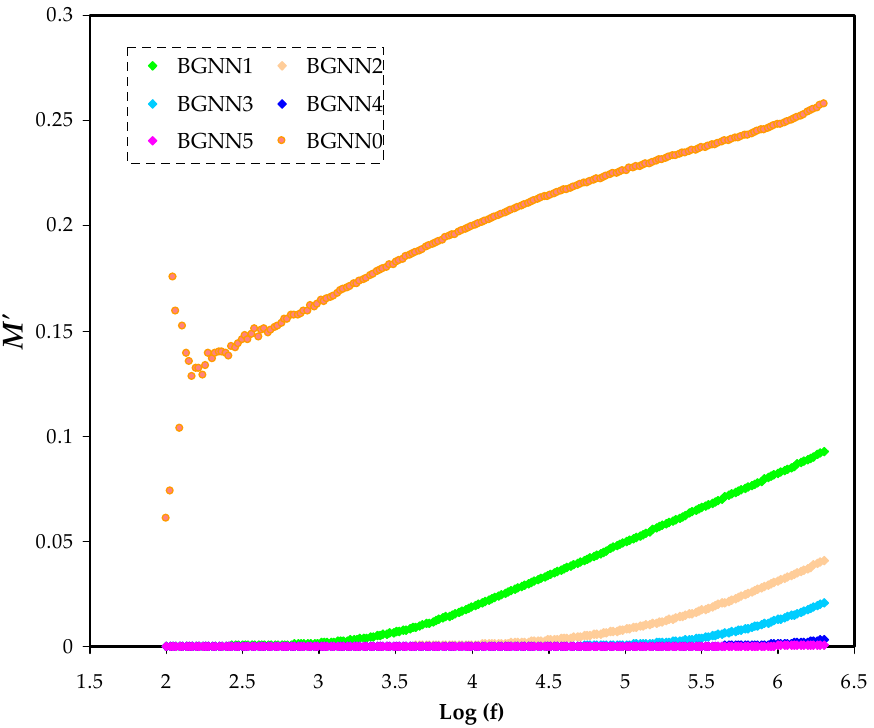
Figure 7. The M (cid:48) spectra for the NBG electrolyte systems. Figure 7. TheM’ spectra for the NBG electrolyte systems. Figure 7. TheM’ spectra for the NBG electrolyte systems.